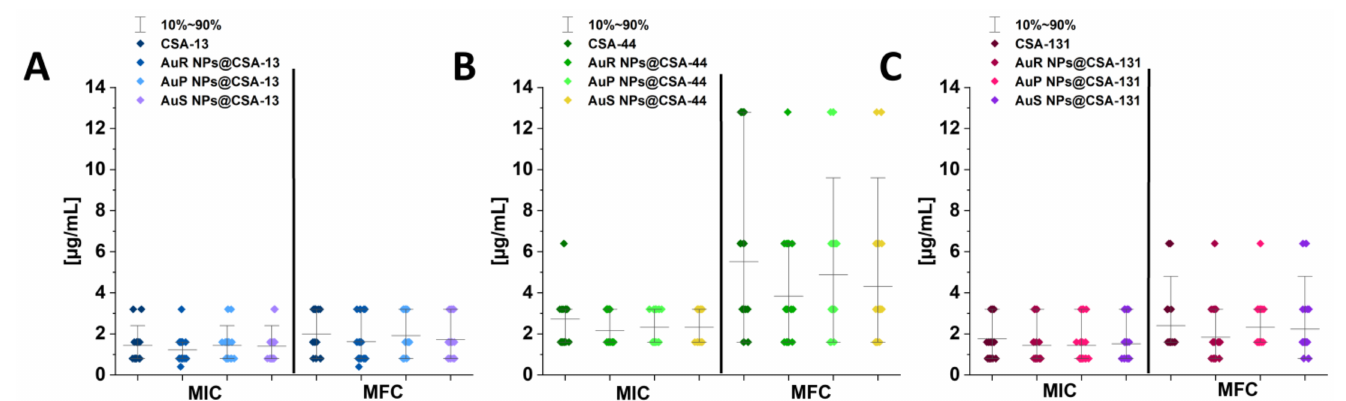
Figure 2. MIC (minimal inhibitory concentration; µ g/mL) and MFC (minimal fungicidal concentration; µ g/mL) values of CSA-13, AuR NPs@CSA-13, AuP NPs@CSA-13, AuS NPs@CSA-13 ( A ); CSA-44, AuR NPs@CSA-44, AuP NPs@CSA-44, AuS NPs@CSA-44 ( B ); and CSA-131, AuR NPs@CSA-131, AuP NPs@CSA-131, AuS NPs@CSA-131 ( C ) against 19 fungal clinical strains and 2 reference fungal